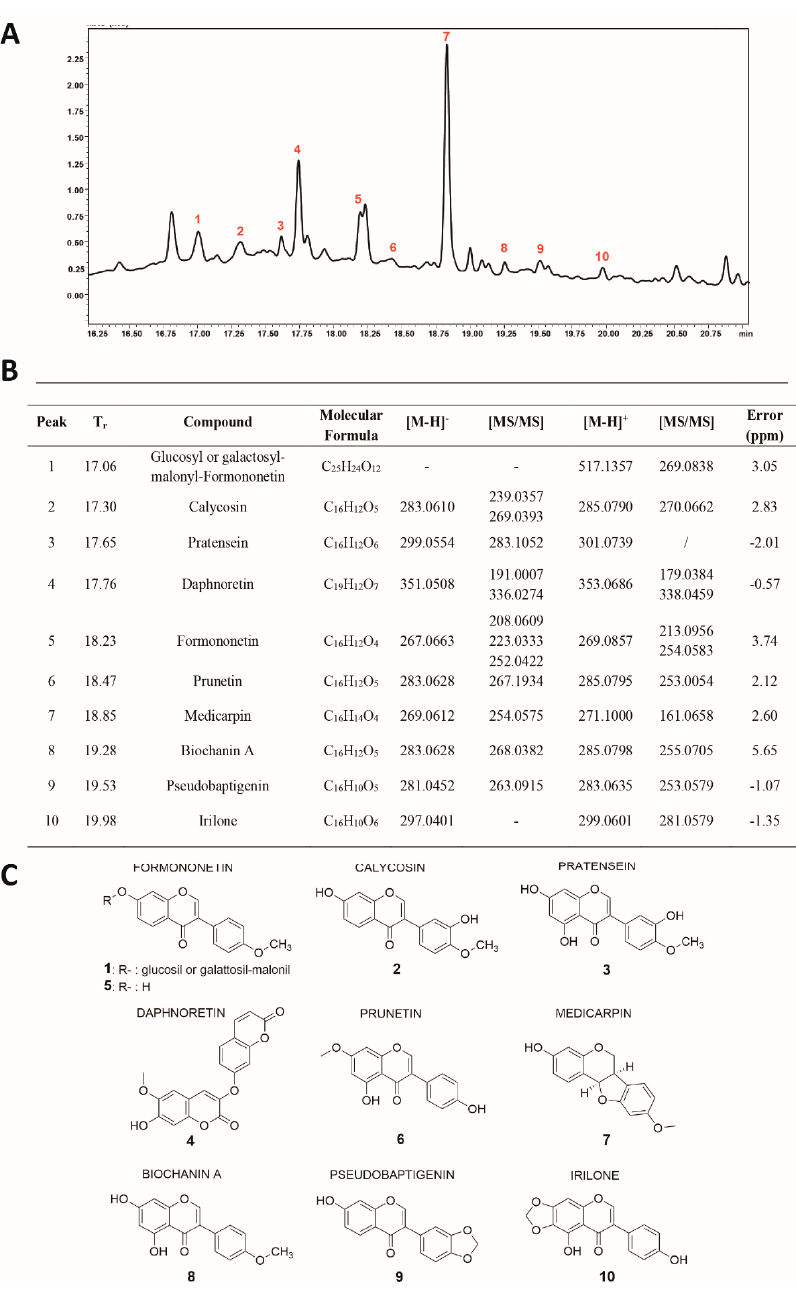
Figure 5. ( A ) Chromatographic profile ( λ : 280 nm), ( B ) list, and ( C ) chemical structures of all polyphenol compounds detected in Fraction D of the TR extract.